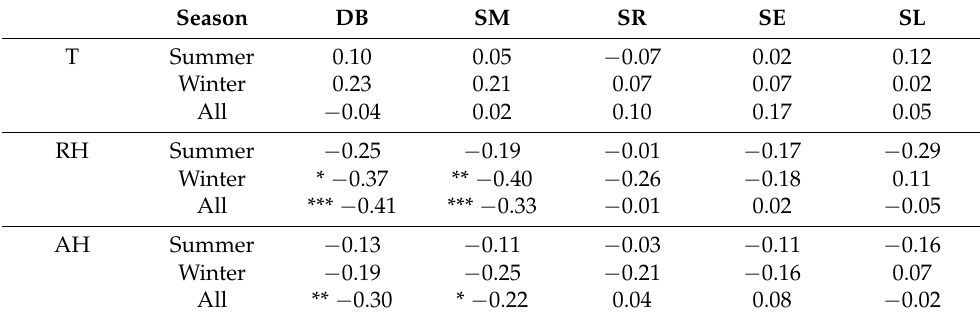
Table 8. Correlation between physical and sleep quality